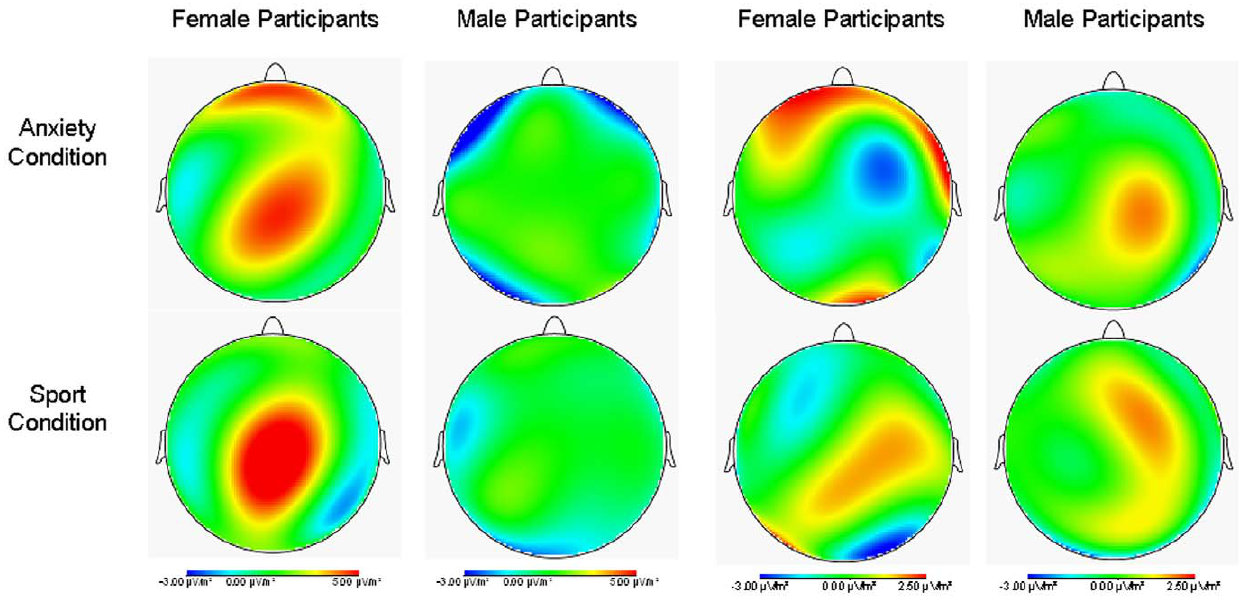
Figure 2. Current Source Density (CSD) maps. Neuronal processing of chemosensory anxiety signals and sport control stimului plotted as CSD maps. The two left columns show the CSDs of non-socially anxious female and male participants plotted for the time point of the maximum P3 amplitude. The two right columns show the CSDs of socially anxious female and male participants plotted for the time point of the maximum N1 amplitude. Blue colors represent a weaker magnitude (neuronal sinks) and red colors represent a stronger magnitude of CSD (neuronal sources). Condition by Sex of Perceiver: F (1, 14) = 6.71, p =0.021 f= 0.69, Power = 0.83; nested effects: Chemosensory Condition within male participants: F (1, 14) =16.37, p = 0.001, f= 1.08, Power = 0.96].